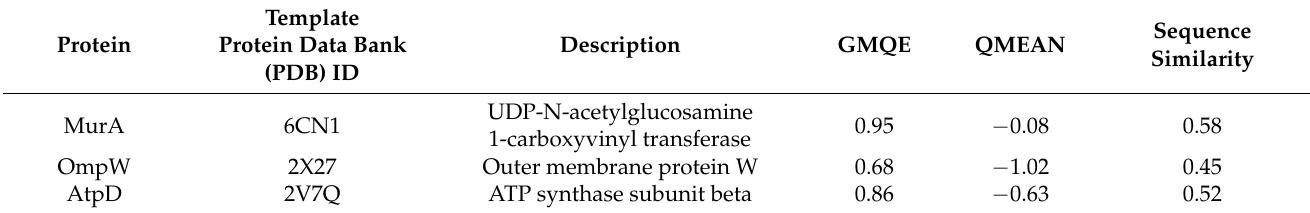
Table 4. Scores of three proteins of P. lundensis .